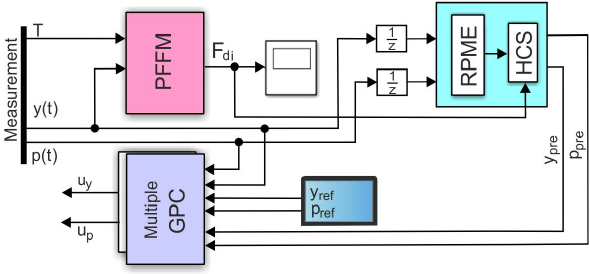
Figure 12: Schematic diagram of the predictive control system of the 80 MN hydraulic